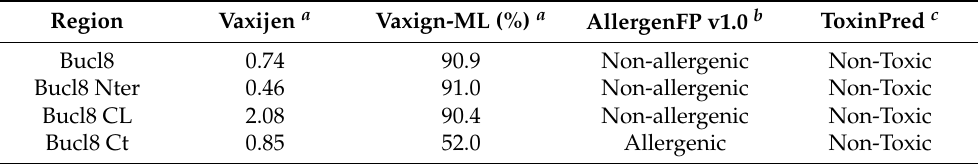
Table 1. Prediction of the antigenicity, allergenicity and toxicity of Bucl8 and isolated domains.